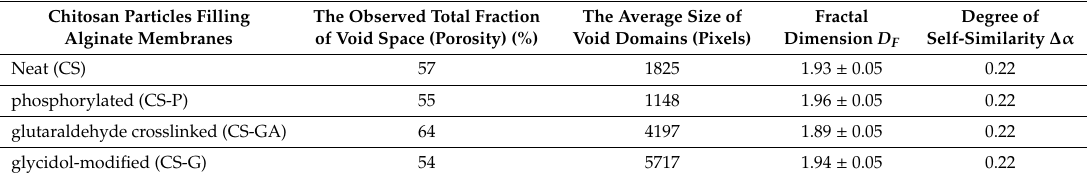
Table 1. Structural properties of alginate membranes filled with various chitosan particles. Chitosan Particles Filling Alginate Membranes